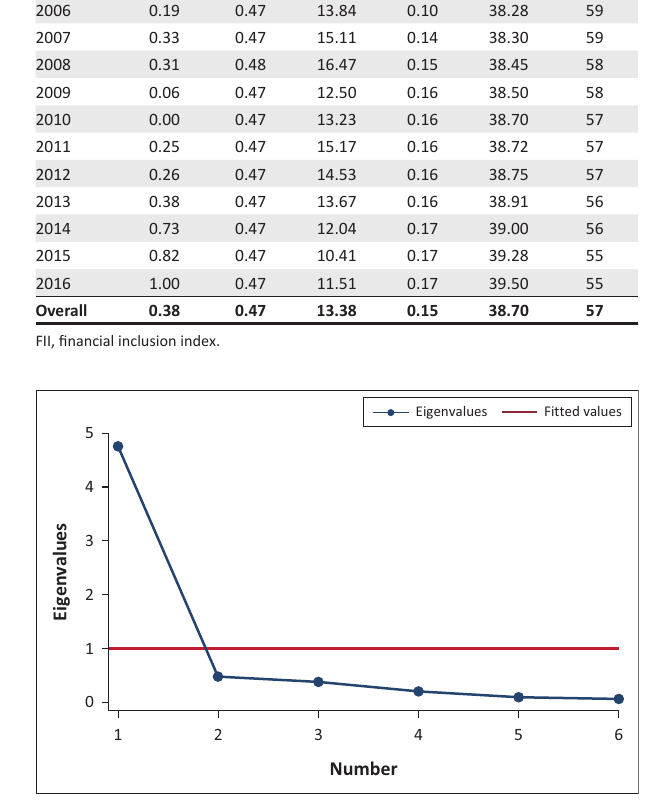
FIGURE 2: Screen plot of the components (of eigenvalues after principal component